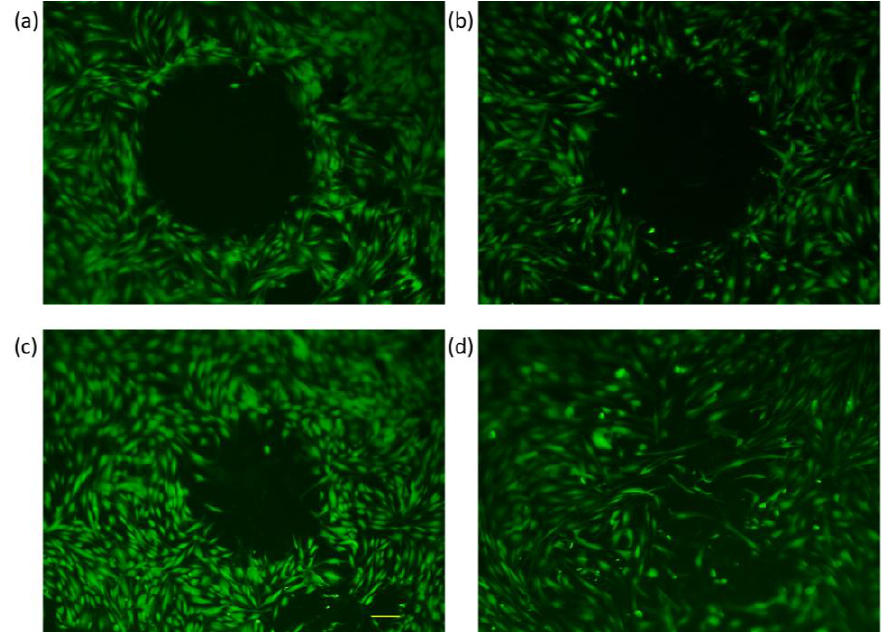
Figure 7. Fluorescence microscopy images of dermal fibroblasts from an 88-year-old donor at four different time frames (Control Group) ( a ) Initial, ( b ) 24 h, ( c ) 48 h, and ( d ) 4 days.